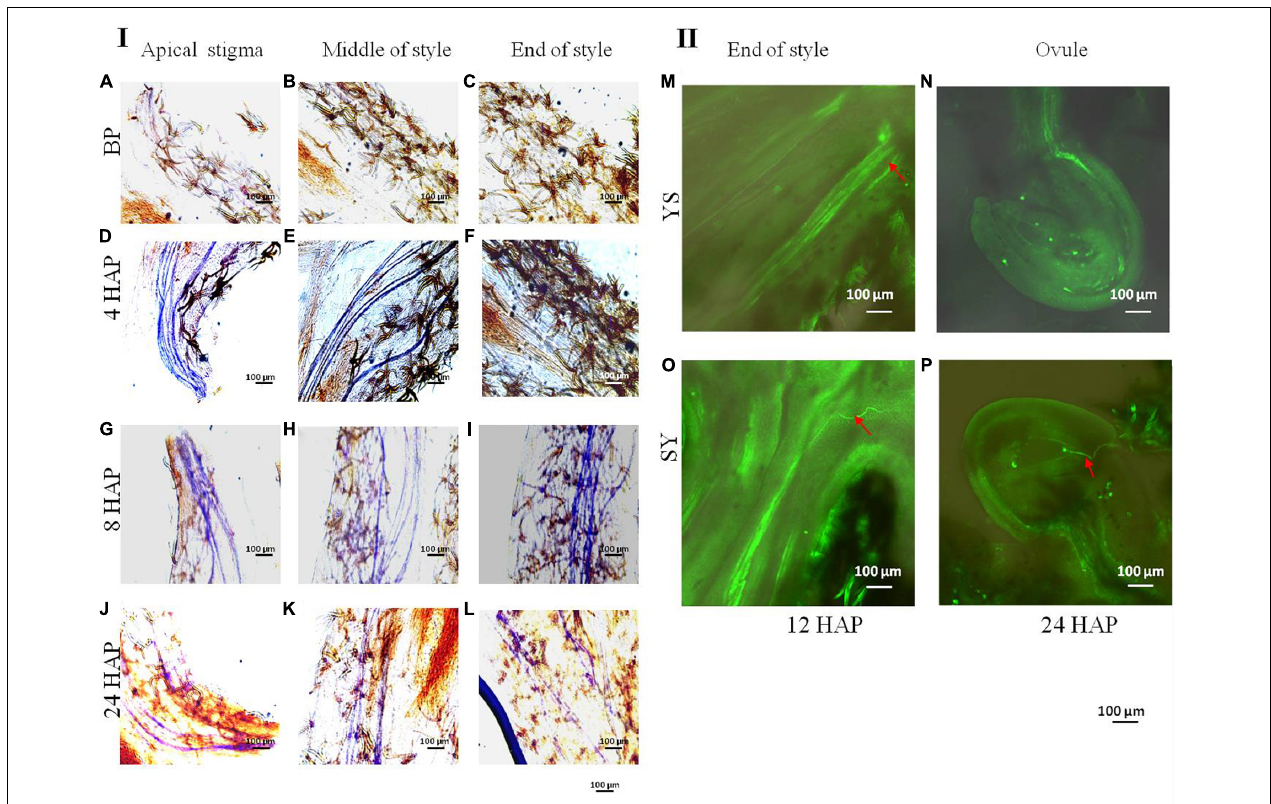
FIGURE 2 | Observation of dynamic growth process of pollen tube. (I) Observation of dynamic growth process of pollen tube before and after pollination with Shixia pollen by in situ germination under an upright fluorescence microscope. (A) Stigma before pollination. (B) Middle of style before pollination. (C) End of style before pollination. (D) Stigma 4 h after pollination. (E) Middle part of style 4 h after pollination. (F) End part of style 4 h after pollination. (G) Stigma 8 h after pollination. (H) Middle part of style 8 h after pollination. (I) End part of style 8 h after pollination. (J) Stigma 8 h after pollination. (K) Middle part of style 8 h after pollination. (L) End of style 24 h after pollination. The pollen tube is blue after being stained with ultraviolet light. (II) Observation of the dynamic growth process of pollen tube by in situ germination method under a confocal laser scanning microscope in reciprocal crosses of Yiduo and Shixia. (M) Yiduo × Shixia 12 h after pollination. (N) Yiduo × Shixia 24 h after pollination. (O) Shixia × Yiduo 12 h after pollination. (P) Shixia × Yiduo 24 h after pollination. The red arrow points to the pollen